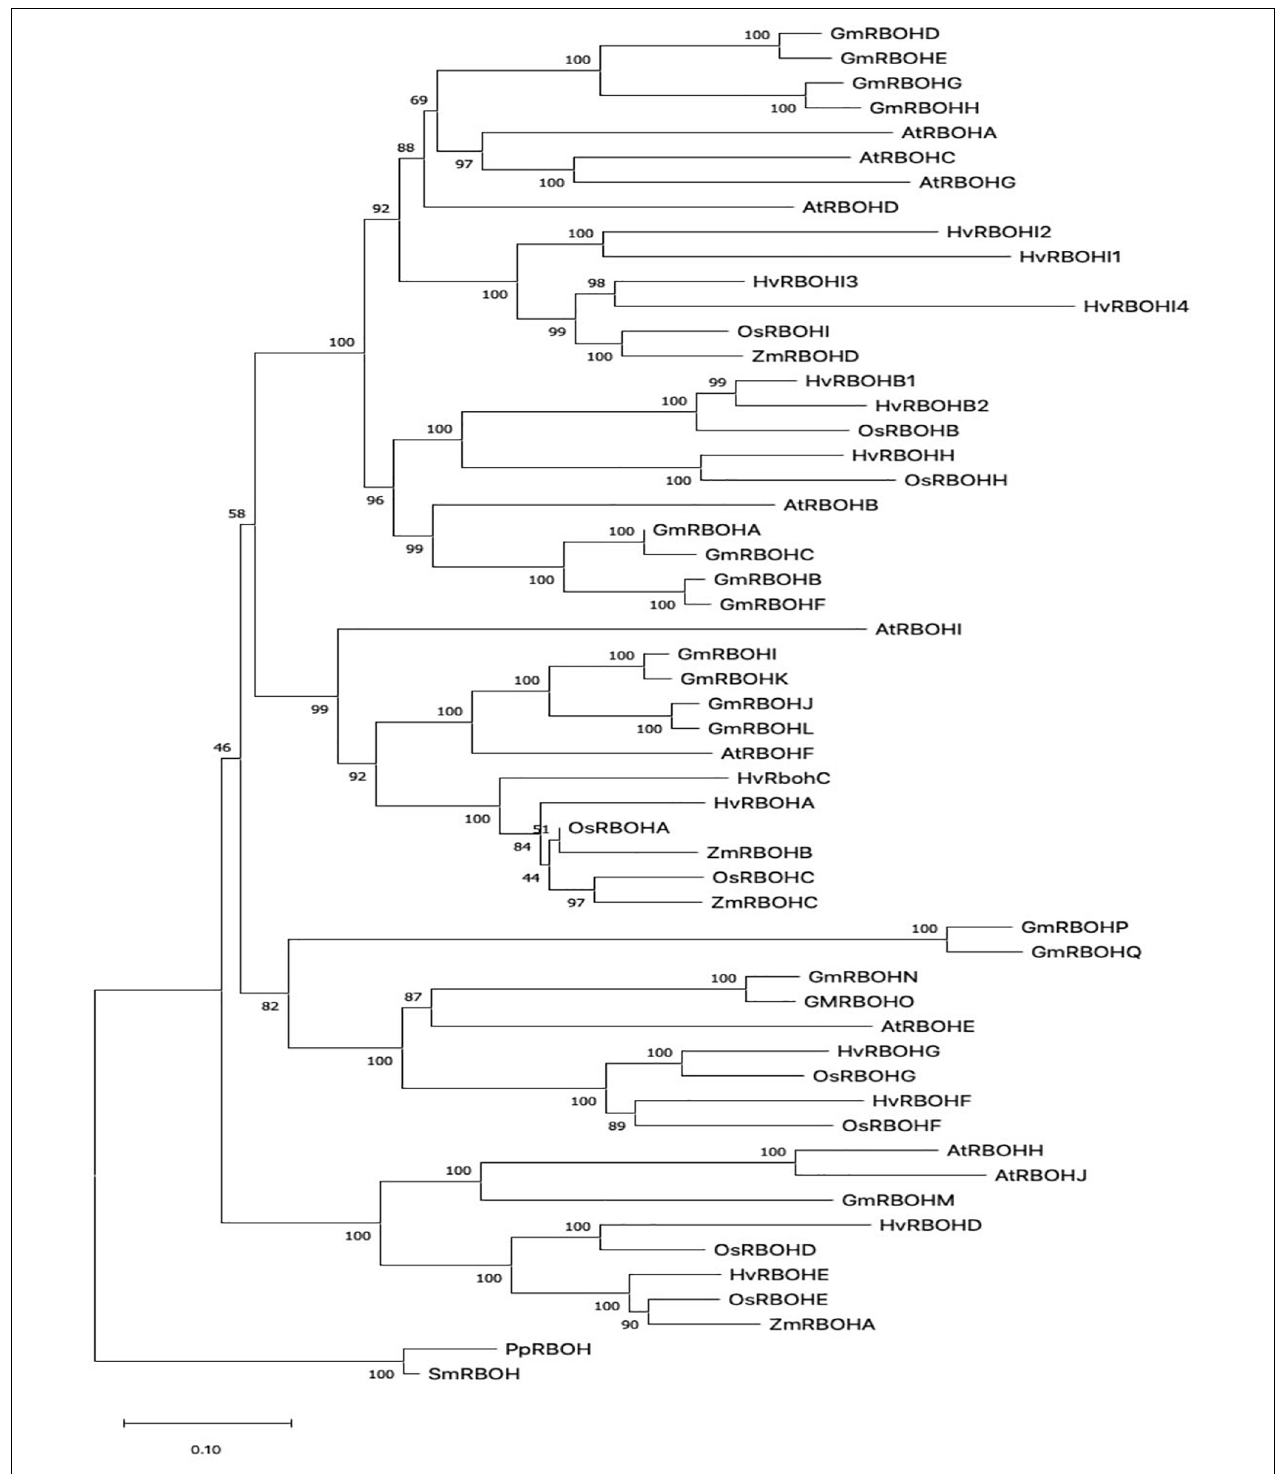
FIGURE 1 | The evolutionary history of plant RBOH protein sequences inferred using the Neighbor-Joining method. The percentage of replicate trees in which the associated taxa clustered together in the bootstrap test (1,000 replicates) are shown next to the branches (Felsenstein, 1985). The tree is drawn to scale, with branch lengths in the same units as those of the evolutionary distances used to infer the phylogenetic tree.